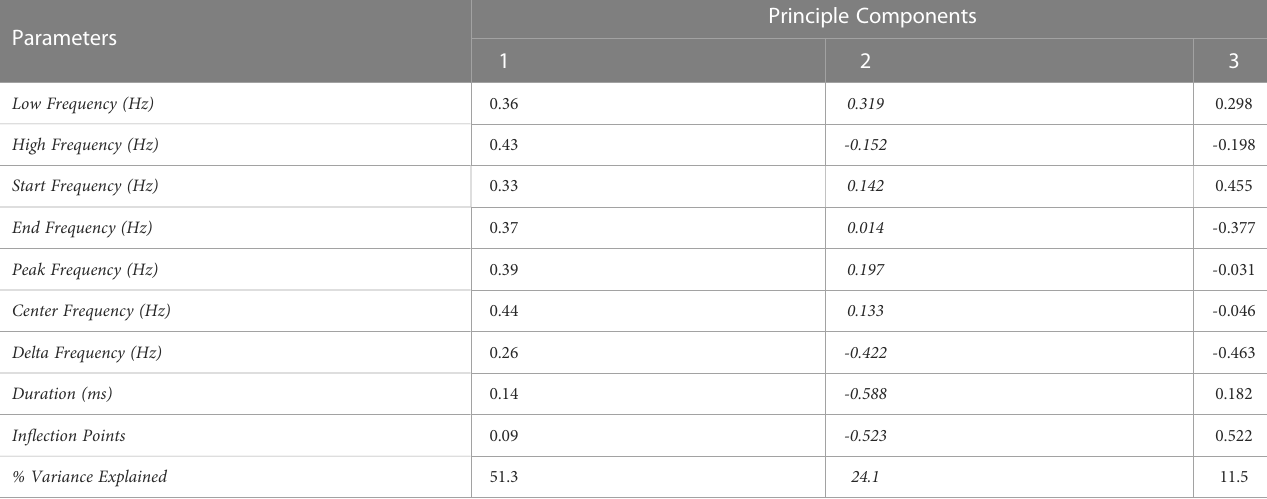
TABLE 2 The loading scores and the proportion of explained variance for each principal component for bottlenose dolphin whistles recorded in the Taranto Gulf and Boka Bay.